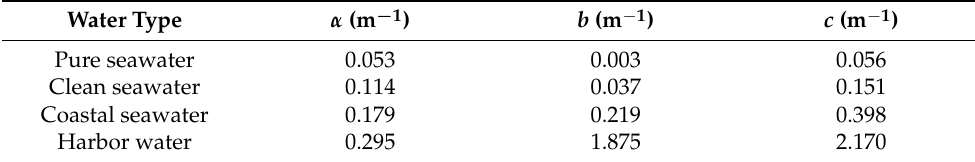
Table 1. Typical values of attenuation coefficient for seawater.